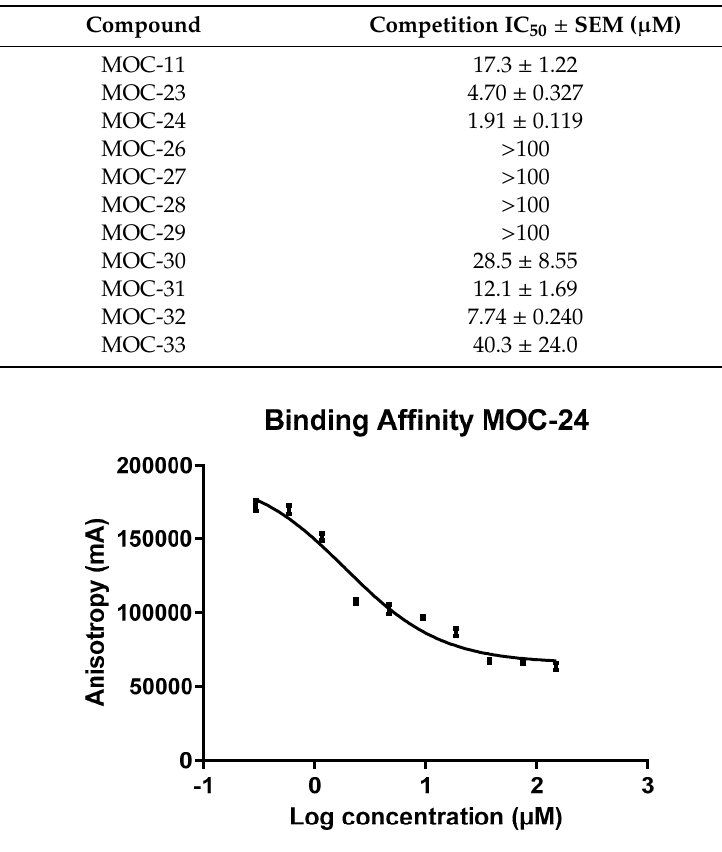
Figure 4. Fluorescence anisotropy competition assay for MOC-24. The emitted fluorescence was measured (480/520 nm) proportional to the amount of bound FITC-NS4A 21` – 33` (Y axis).